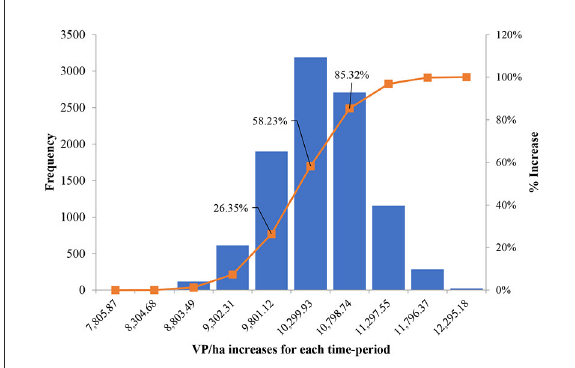
FIGURE1 Derived from current research data. Crops proportionality was distributed as follows: Peanuts − 9 hectares; Sugar Cane − 42 hectares; Corn − 5 hectares; Soya − 19 hectares, with annual crops are rotated with summer corn.